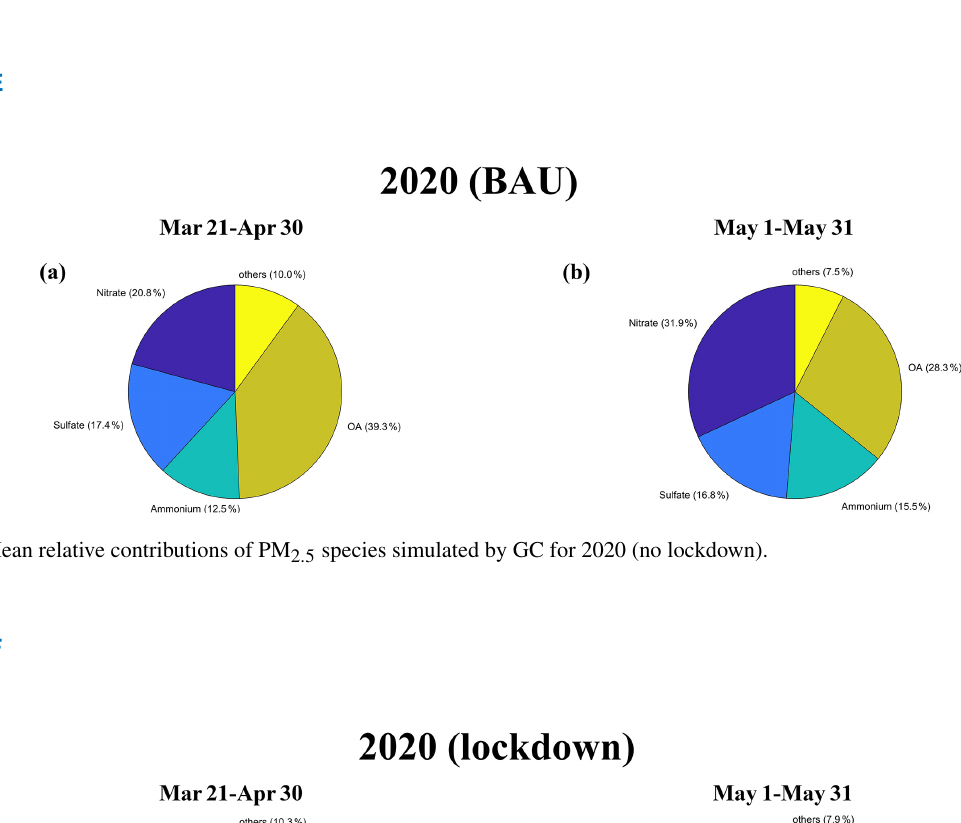
Figure D1. Mean relative contributions of PM 2 . 5 species simulated by GC for 2019.